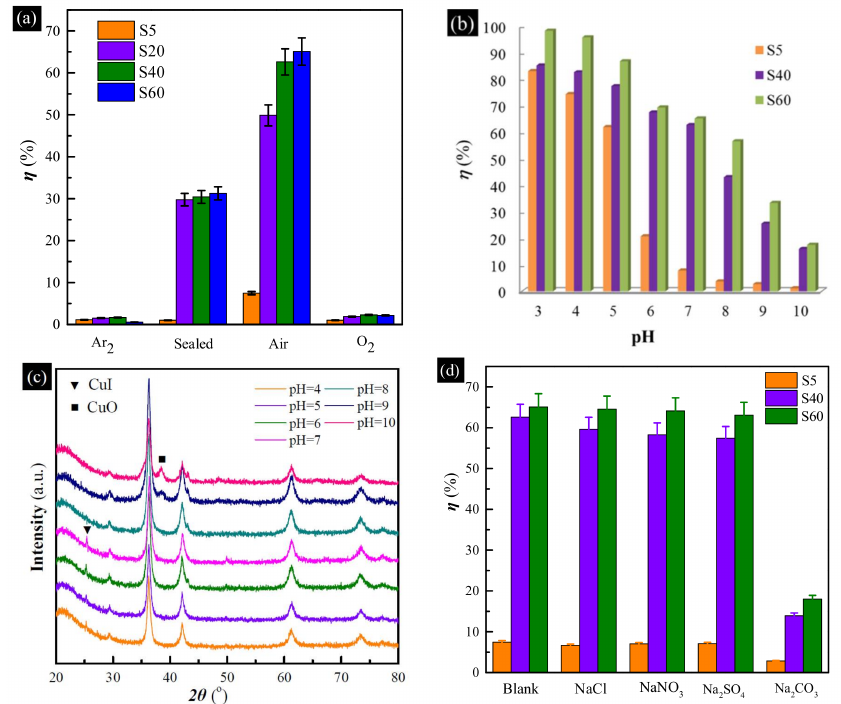
Figure 6. ( a ) Effect of different atmospheres on the uptake of I − anions by hollow Cu-based adsorbents; ( b ) uptake efficiency of I − anions in the pH range from 3 to 10; ( c ) XRD patterns of S40 after the uptake of I − anions at different pH values; ( d ) effect of high competitive anions on the uptake of I − anions by hollow Cu-based